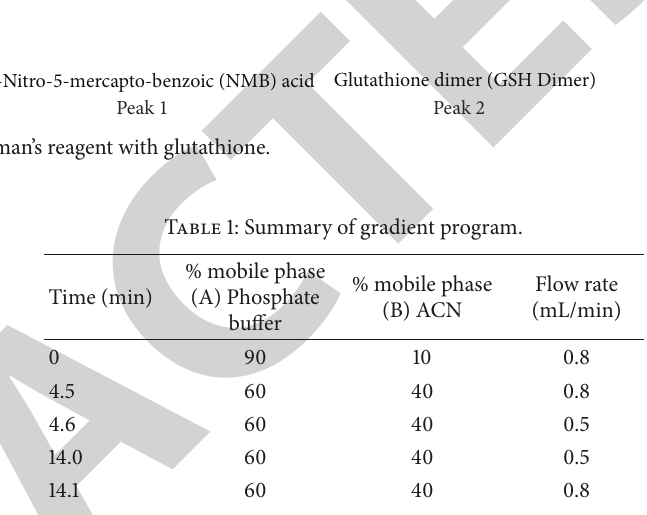
Figure 1: Reaction of Ellman’s reagent with glutathione.